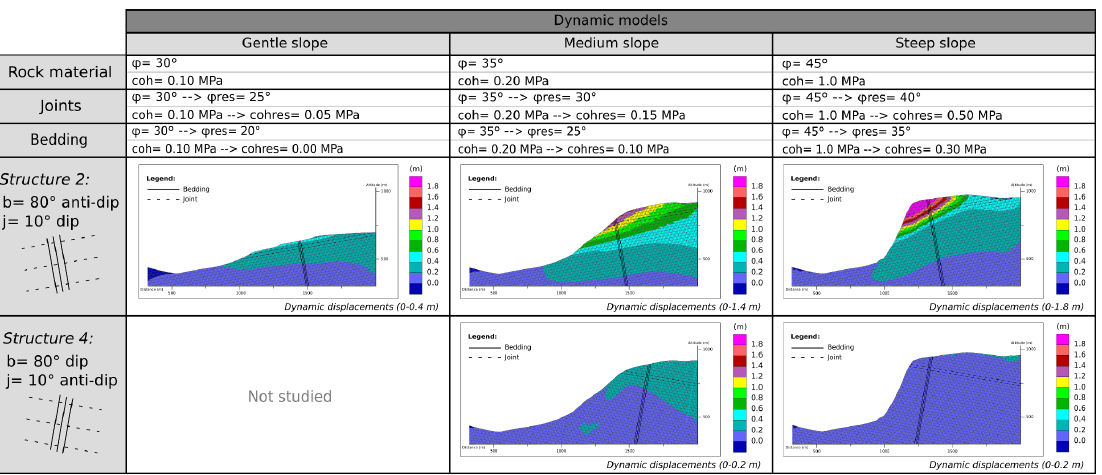
Figure 17. Dynamic modelling results (in terms of displacements) for the three rock slope cases with structure 1 and